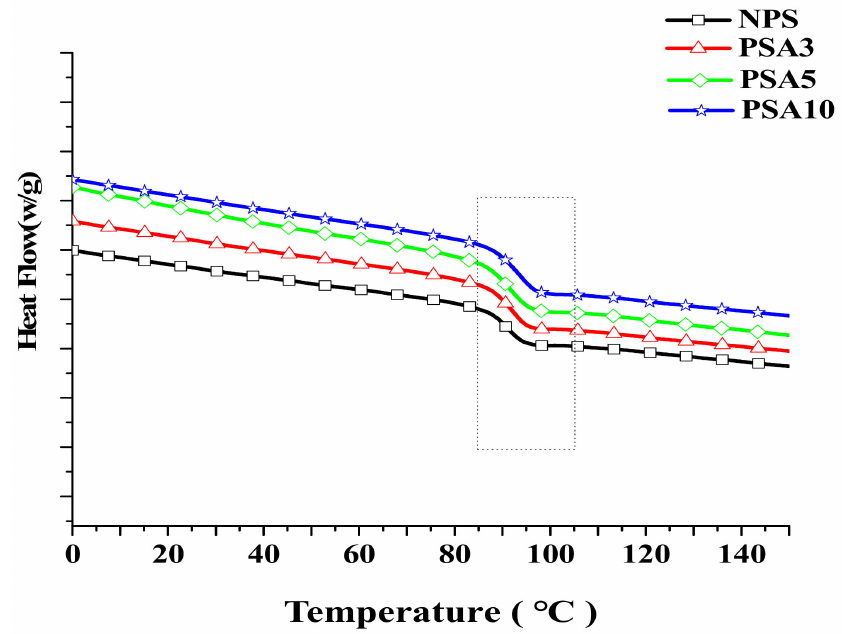
Figure 12. The measured heat flow curves from DSC for the Type I samples. Table 4. The important parameters obtained from DSC measurements of samples prepared in this